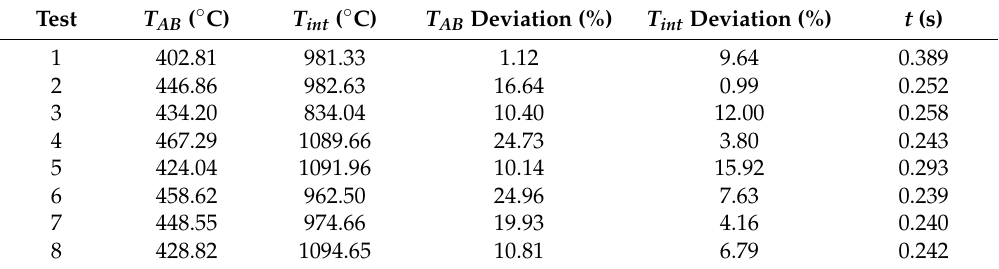
Table 3. Temperature prediction and validation in the orthogonal machining of AISI 1045 steel.